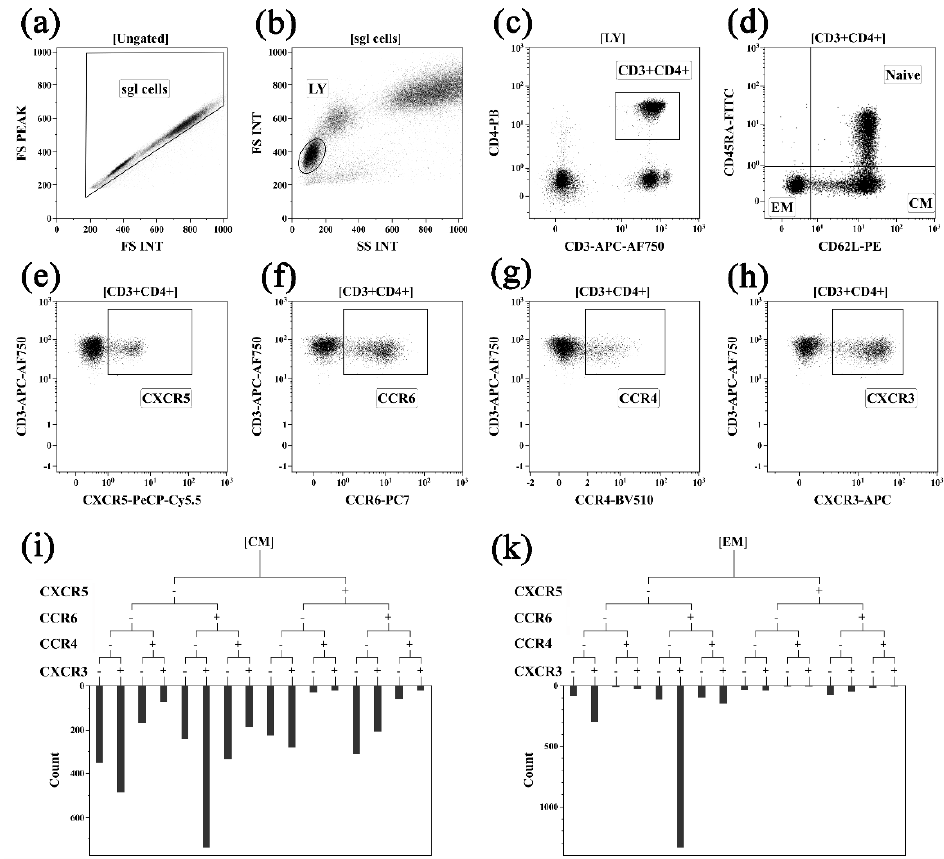
Figure 1. Flow cytometric gating strategy used to identify main Th cell subsets. ( a ) Singlet gating based on FS PEAK versus FS INT (the region is set to discriminate cell doublets); ( b ) Lymphocytes were gated on the side scatter/forward scatter plot with a “LY” gate; ( c ) Th cells were identified from the gate of lymphocytes as “CD3 + CD4 + ” ( d ) and then separated into differentiated subsets using CD45RA and CD62L expression (‘naïve’ Th were CD45RA + CD62L + ; central memory Th were CD45RA – CD62L + ; effector memory Th were CD45RA – CD62L – and “terminally differentiated CD45RA-positive” Th cells were CD45RA + CD62L – ). Histograms ( e – h )—expression of CXCR5, CCR6, CCR4 and CXCR3, respectively, by total Th cell population; regions “CXCR5”, “CXCR3”, “CCR6” and “CCR4” were used as branches for hierarchical tree histograms ( i , k ). Hierarchical tree histograms were gated on CM and EM Th—( i , k ), respectively). The frequency histograms below the trees indicates the relative proportion of cells in each subset that expressed CXCR5, CXCR3, CCR6 and CCR4 within CM and EM Th.